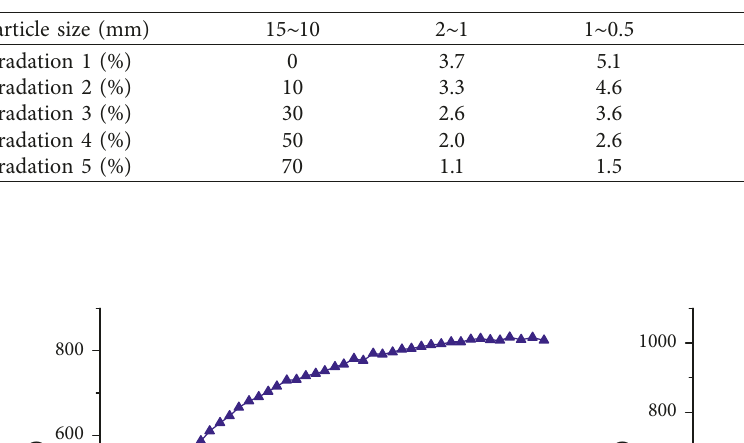
Table 2: Gradation of soil-rock mixture with different stone